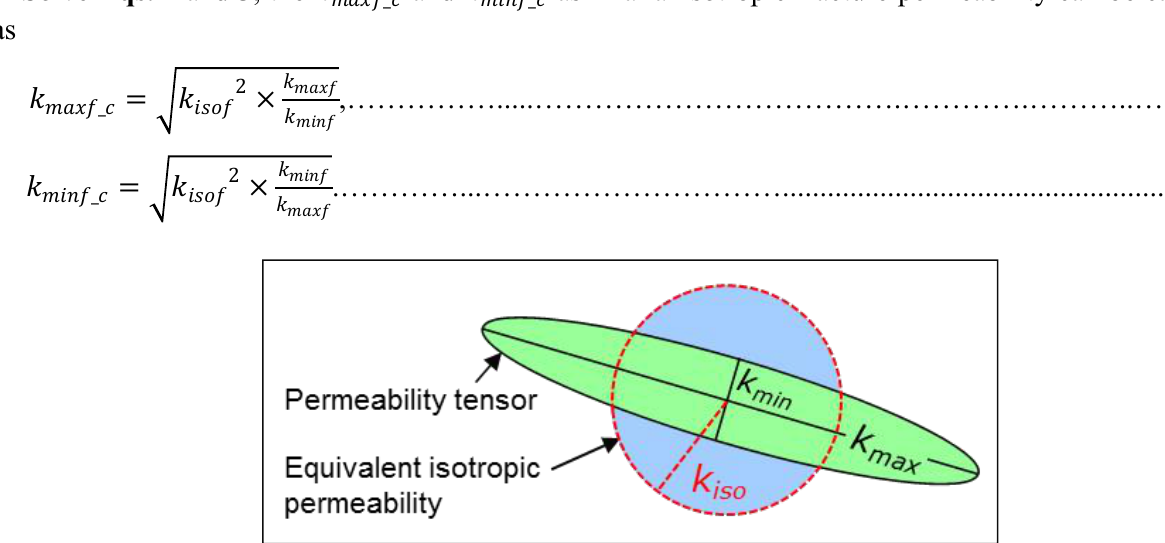
Figure 11—Permeability Tensor and the Equivalent Isotropic Permeability (Courtesy Wayne